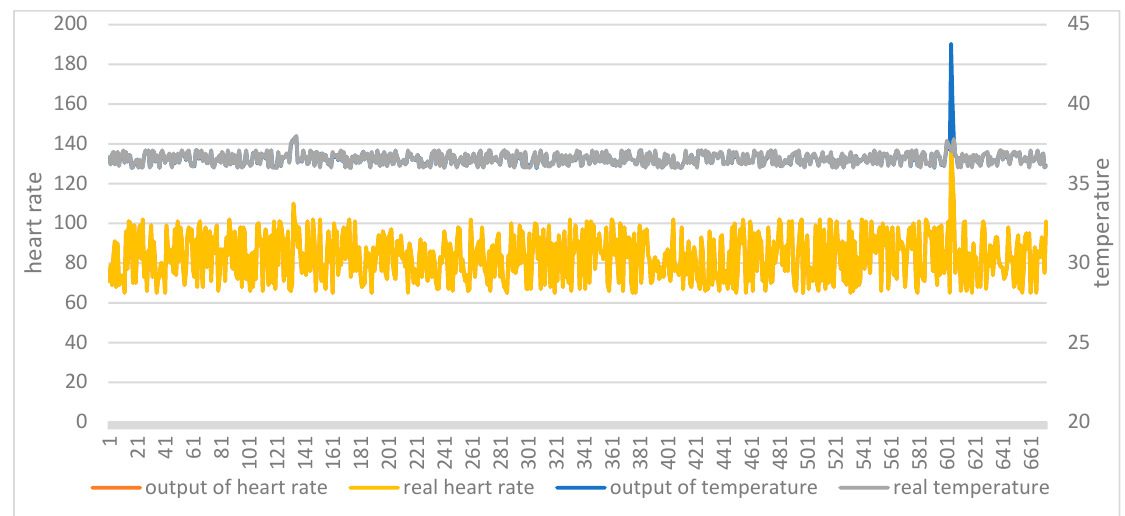
Figure 14. Comparison of input and output of GRU-AE model in test set 1.